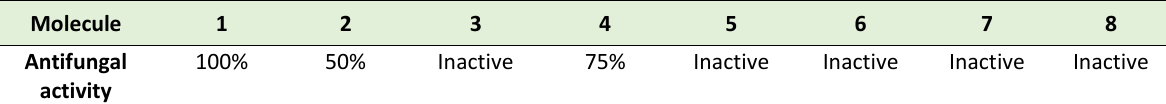
TABLE 1 . Antifungal activities of drimane sesquiterpenoids 1 – 8 against C. albicans SC5314.